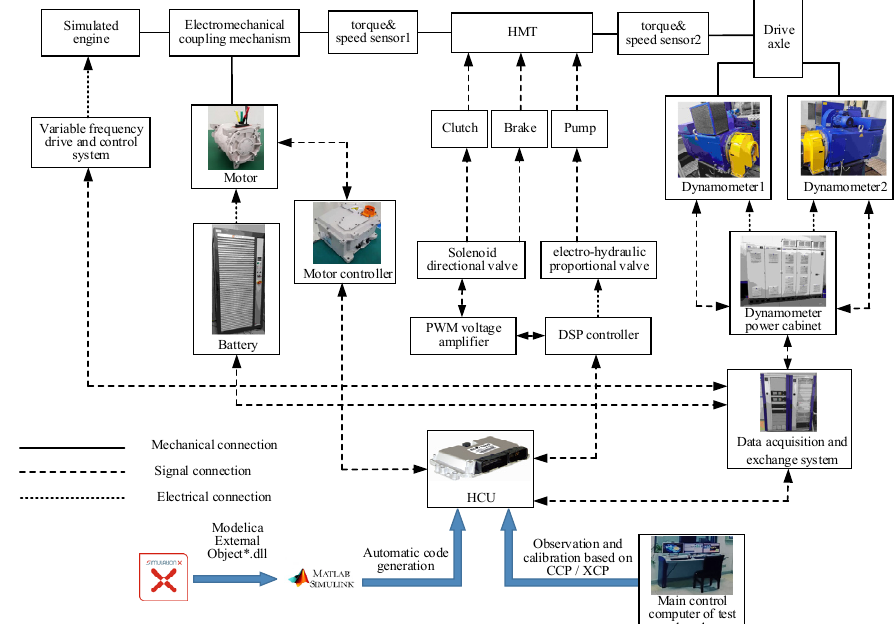
Figure 15. Test bench architecture scheme.